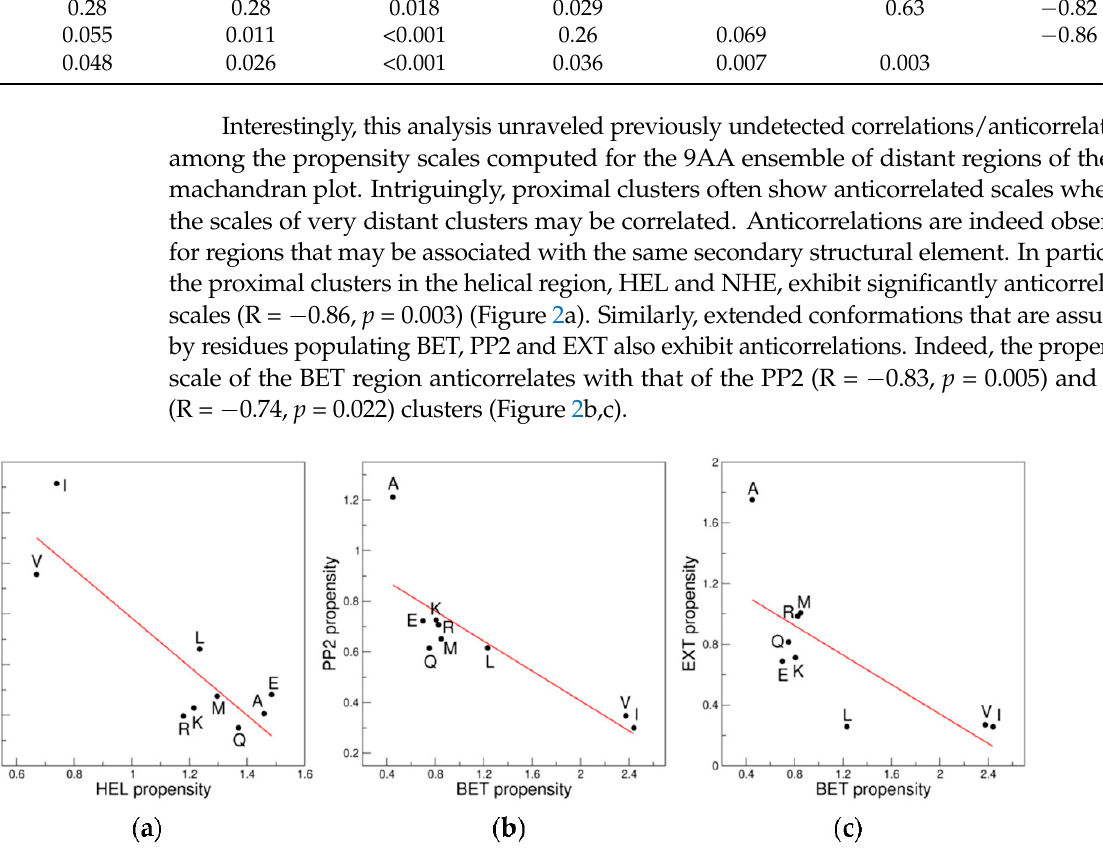
Figure 3. Examples of correlation/anticorrelations of the propensity scales of distant clusters: ( a ) EXT versus PP2; ( b ) BET versus NHE; and ( c ) BET versus HEL. The 9AA ensemble is considered. The analysis of the data reported in Table 1 indicates that five clusters (EXT, BET, PP2, HEL, NHE), which correspond to the highest populated regions of the Ramachan- dran plot, may be divided into two larger groups: (i) G1 made of EXT, HEL, and PP2 and; (ii) G2 made of BET and NHE. These groups have the following properties: (1) the pro- pensity scales of the members of each group are significantly correlated; and (2) the scales of clusters belonging to the two groups anticorrelate ( p ranging from 0.048 to 4.7 × 10 − 5 ). The analysis of the propensity scales of the remaining clusters POS and BRI suggests that they may be associated with the G1 group, although the correlations are not always sta- tistically significant. As mentioned above, the trends highlighted on the reduced set of nine residues were evaluated considering the eighteen non-Pro/non-Gly protein residues (Table 2).